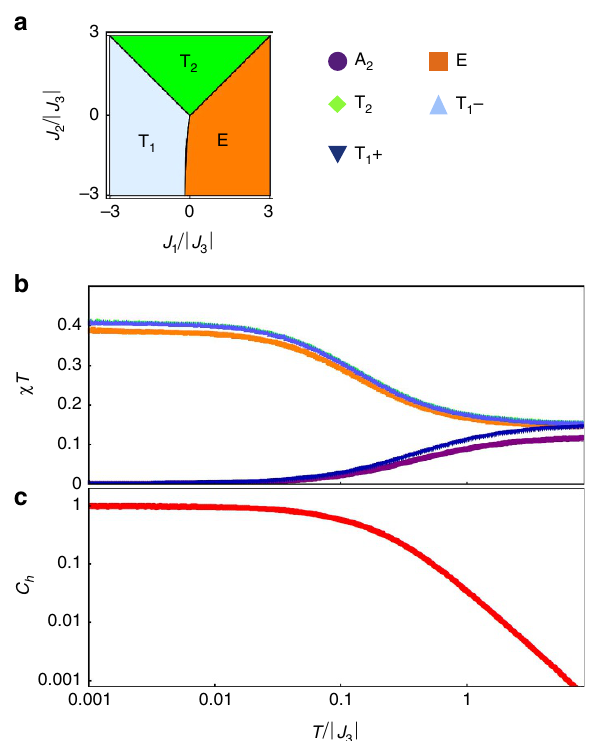
Figure 2 | Evidence of spin-liquid behaviour from Monte Carlo simulation. ( a ) Classical ground-state phase diagram of H ex (equation (1)) for J 3 o 0, in the plane J 4 ¼ 0, showing how ordered phases with symmetry T 1 , E and T 2 meet at the point J 1 ¼ J 2 ¼ 0 (ref. 16). ( b ) Order-parameter susceptibilities and ( c ) heat capacity calculated in classical Monte Carlo simulation of H ex (equation (1)), for parameters J 1 ¼ J 2 ¼ J 4 ¼ 0, J 3 o 0. No phase transition is observed down to T ¼ 0.001 | J 3 |. Instead, the order- parameter susceptibilities of neighbouring ordered phases exhibit a Curie law crossover, characteristic of a Coulombic spin-liquid 54 . The symbols used for different symmetry channels are shown in the